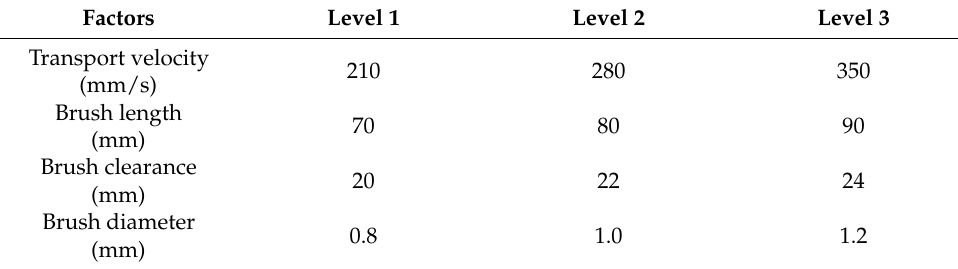
Table 2. Controllable factors and their levels for conveyor-type calyx remover.